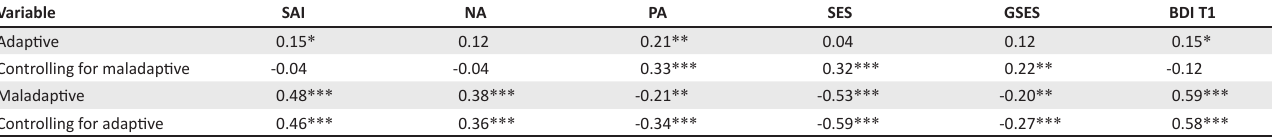
TABLE 3: Regression of BDI T1 on perfectionism (cross-sectional multiple regression analyses).